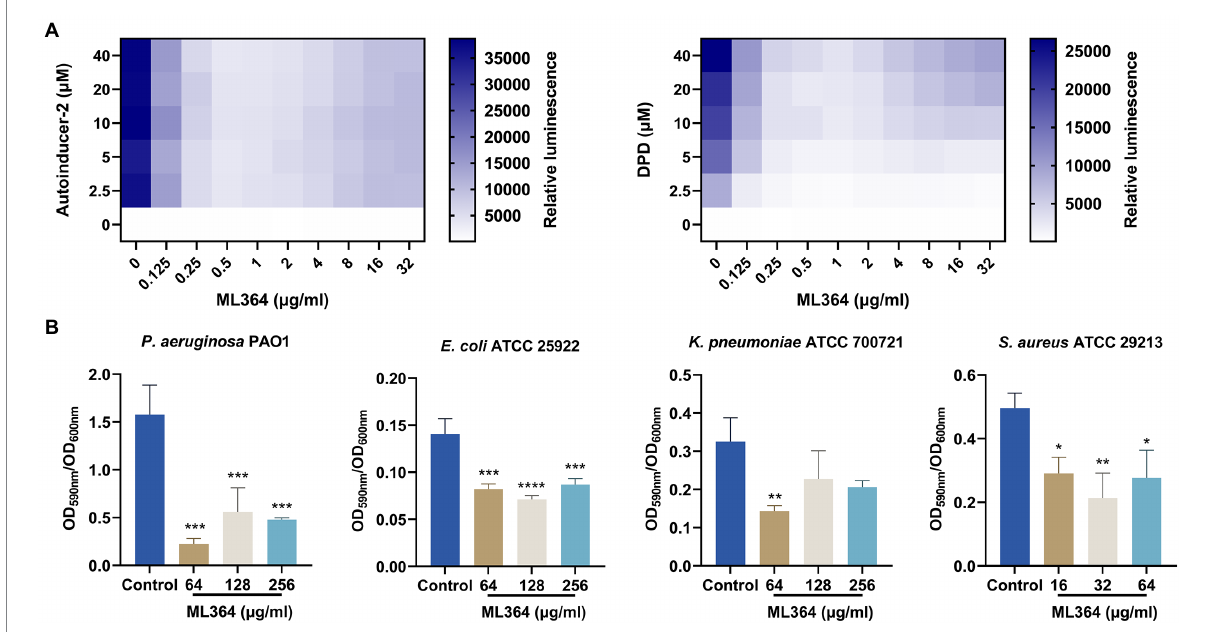
FIGURE 3 ML364 blocks DPD/AI-2 signaling response and inhibit biofilm formation of different species of bacteria. (A) The AI-2 and DPD signaling response of Vibrio Campbellii MM32 (LuxN − , LuxS − ) treated with various concentrations of ML364. (B) The biofilm quantification of Pseudomonas aeruginosa PAO1, Escherichia coli ATCC 25922, Klebsiella pneumoniae ATCC 700721 and Staphylococcus aureus ATCC 29213 treated with ML364. Data were calculated with one-way ANOVA and Bonferroni’s multiple comparisons, compared to those of the control groups; * p < 0.05,